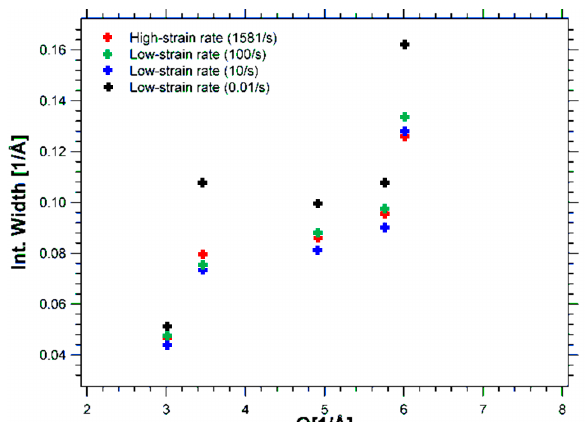
Figure 8. Diffraction profile of the four specimens deformed at different strain rates.